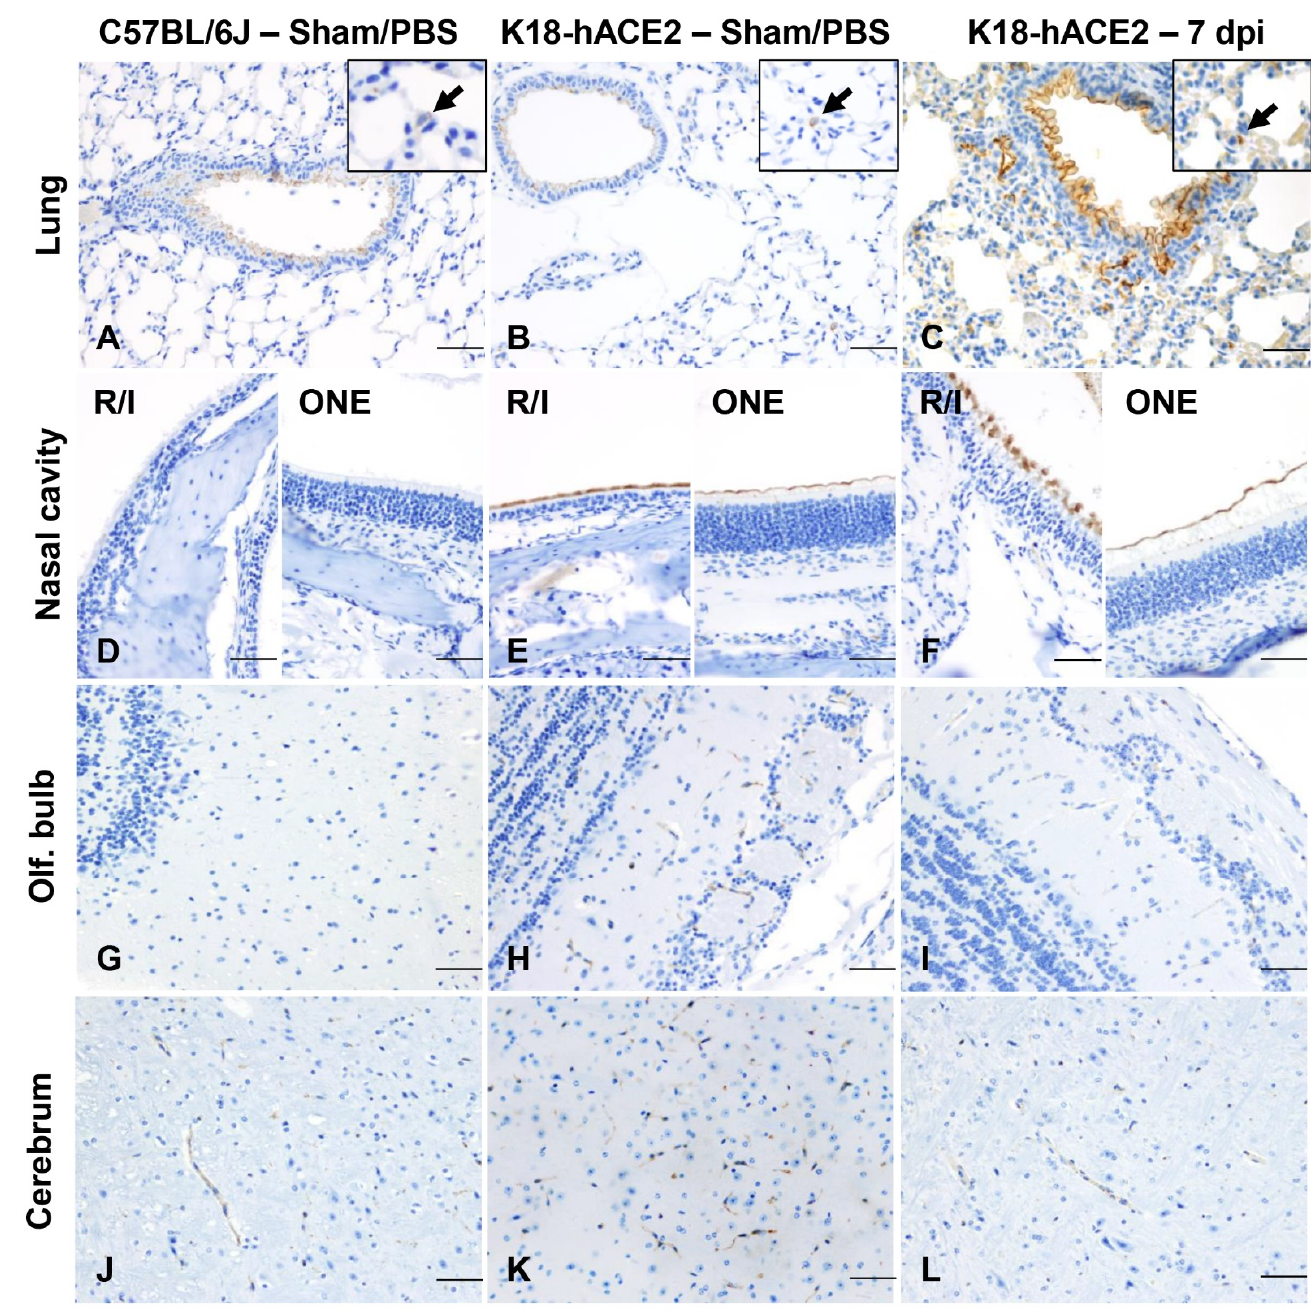
Figure 9. Distribution of ACE2 in lungs, nasal cavity, brain, and olfactory bulb of wild-type C57BL/6J and uninfected and SARS-CoV-2 infected K18-hACE2 mice. Lung ( A – C ), nasal (rostral/intermediate turbinates [R/I]) and olfactory epithelium (ONE) ( D – F ), olfactory bulb ( G – I ) and brain ( J – L ) from non-infected C57BL/6J, and from non-infected and infected K18-hACE2 mice (7 dpi). K18-hACE2 mice were analyzed via immunohistochemistry using a cross-reactive anti-ACE2 antibody. In the lungs ( A – C ), ACE2 expression (brown) was mostly restricted to the apical membrane of bronchiolar epithelial cells with scattered positive AT2 cells (inset arrows). Nasal (rostral/intermediate turbinates [R/I]) and olfactory epithelium (ONE) were devoid of ACE2 in C57BL/6J mice ( D ), but expression was enhanced in K18-hACE2 mice with intense apical expression ( E , F ). ACE2 expression within the olfactory bulb ( G – I ) and the brain ( J – L ) was restricted to capillary endothelium with no neuronal expression. DAB, 200X total magnification. Bar = 100 μ m.